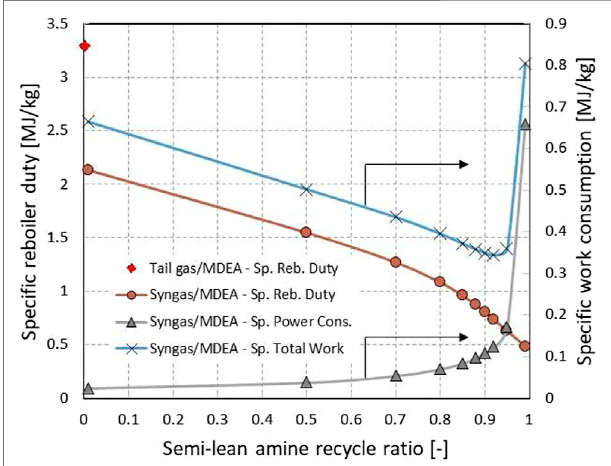
FIGURE8| Energyconsumptionofa40wt%aqueousMDEAprocessin case of CO 2 capture from the syngas or tail gas under equilibrium-controlled